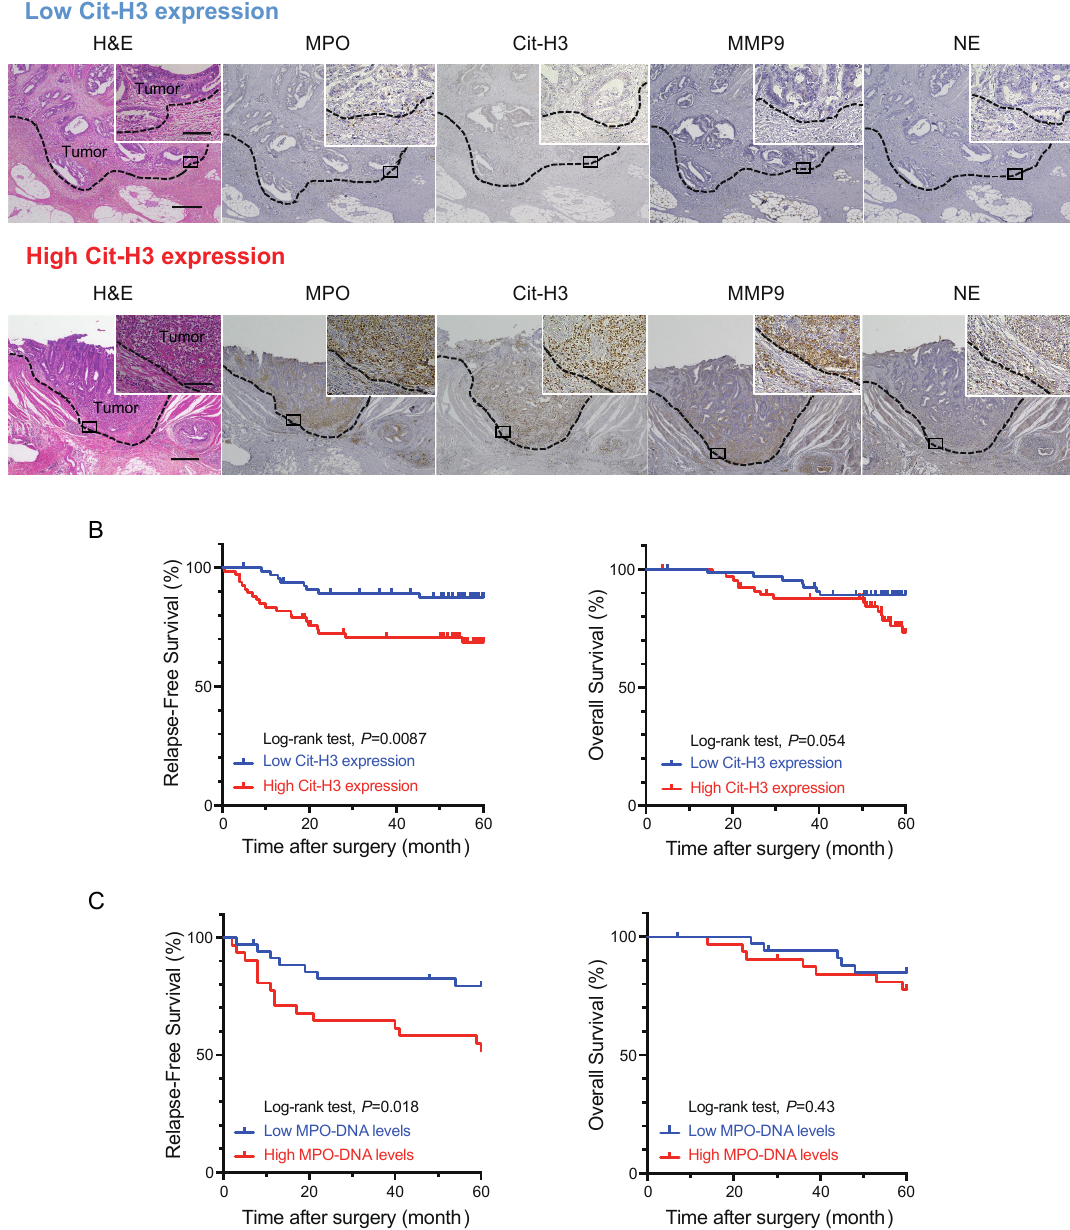
Figure 1. Intratumoral and systemic neutrophil extracellular trap (NET) formation correlates with poor prognoses in colorectal cancer (CRC) patients. ( A ) Hematoxylin and eosin staining (H&E) and immunohistochemical (IHC) staining for myeloperoxidase (MPO), citrullinated histon H3 (Cit-H3), matrix metalloproteinase 9 (MMP9) and neutrophil elastase (NE) in primary CRC specimens. Upper and lower panels show serial sections of representative high and low expression of Cit-H3 in CRC specimens, respectively. Scale bars, 500 µ m. Magnified images are shown in right upper quadrant. Scale bars, 100 µ m. ( B ) Effects of Cit-H3 expression on relapse-free survival (RFS) (right) and overall survival (OS) (left) in patients who underwent curative resection of stage I–III CRC (Kaplan–Meier estimates). p values were calculated using the log-rank test. ( C ) Effects of preoperative serum MPO– DNA levels on RFS (right) and OS (right) in patients who underwent curative resection of stage II and III CRC (Kaplan–Meier estimates). p values were calculated using the log-rank